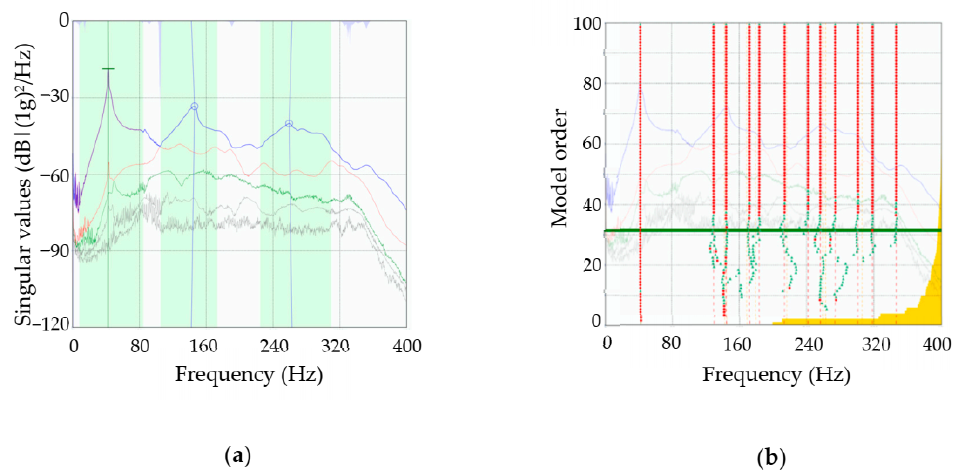
Figure 10. ( a ) Singular values diagram for lumber board #33 (Enhanced Frequency Domain De- composition (EFDD) method); ( b ) stabilization diagram for lumber board #33 (Stochastic Subspace Identification (SSI) method). Adapted from ARTeMIS Modal Pro